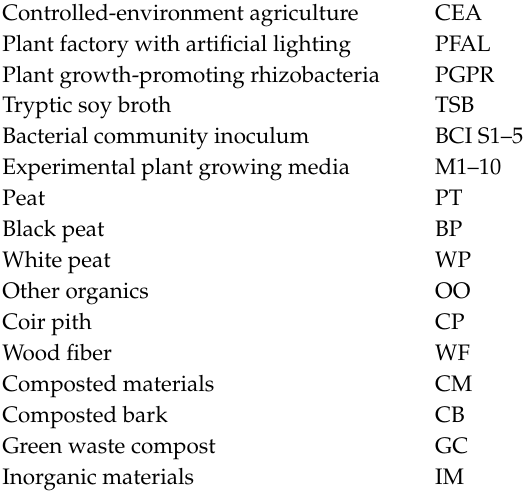
BCI S4 treatment, Figure S38: Interaction e ff ects between substratum raw material groups on carotenoid content under BCI S5 treatment, Table S1: Control factors and level settings for substratum optimization, Table S2: The 2 5 − 2 fractional factorial design, Table S3: Physicochemical properties of the experimental substrata and the commercial substratum, Table S4: Shoot fresh weight response optimization under each BCI treatment, Table S5: Lettuce head area response optimization under each BCI treatment, Table S6: Root fresh weight response optimization under each BCI treatment, Table S7: Shoot dry weight response optimization under each BCI treatment, Table S8: Total Table S11: Carotenoid content response optimization under each BCI